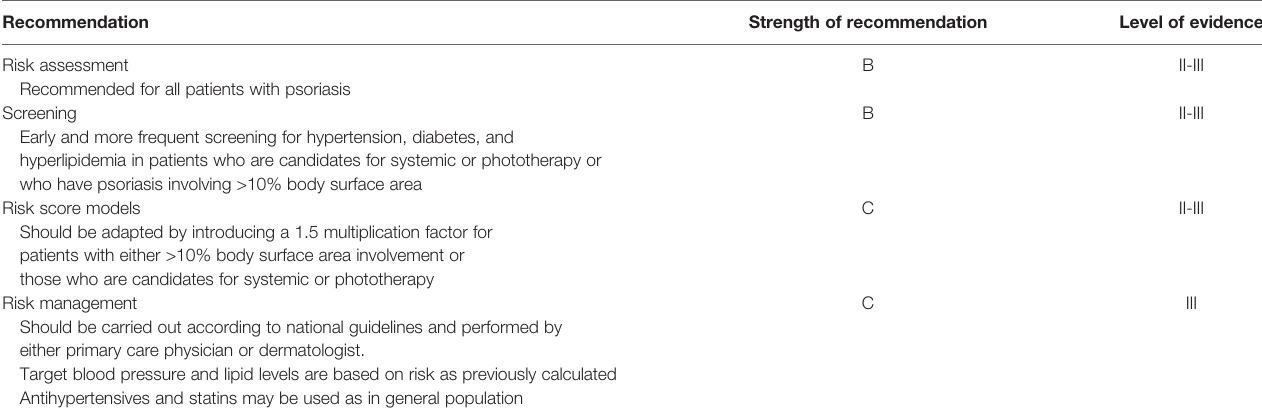
TABLE 3 | Psoriasis and cardiovascular diseases comorbidity strength of recommendation and level of evidence. Recommendation Strength of